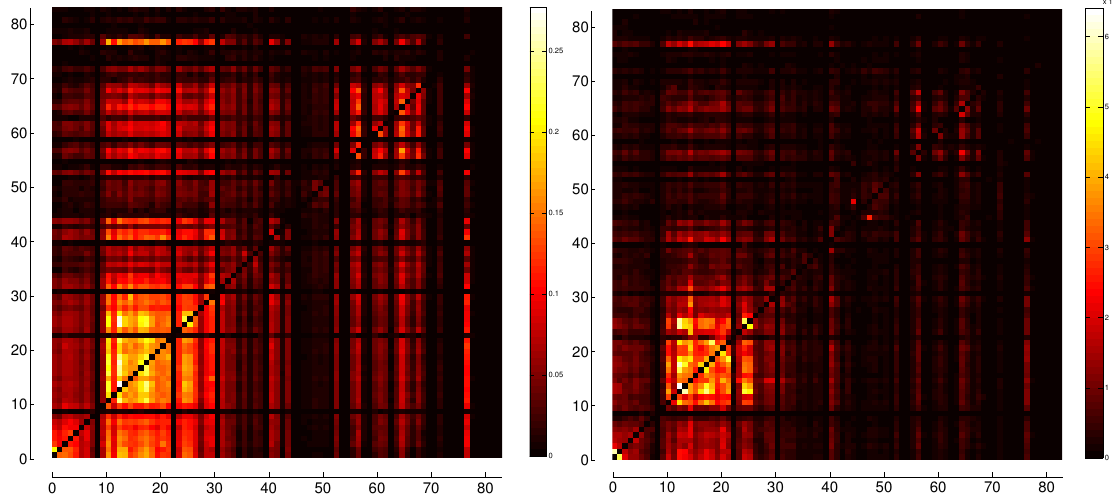
Figure 21. Heat maps of the dependency matrices based on correlation and on LETE, respectively, based on the absolute values of log